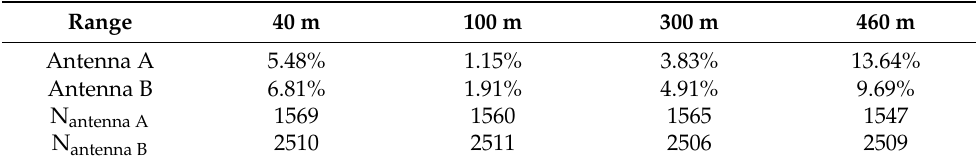
Table 3. Communication data drop